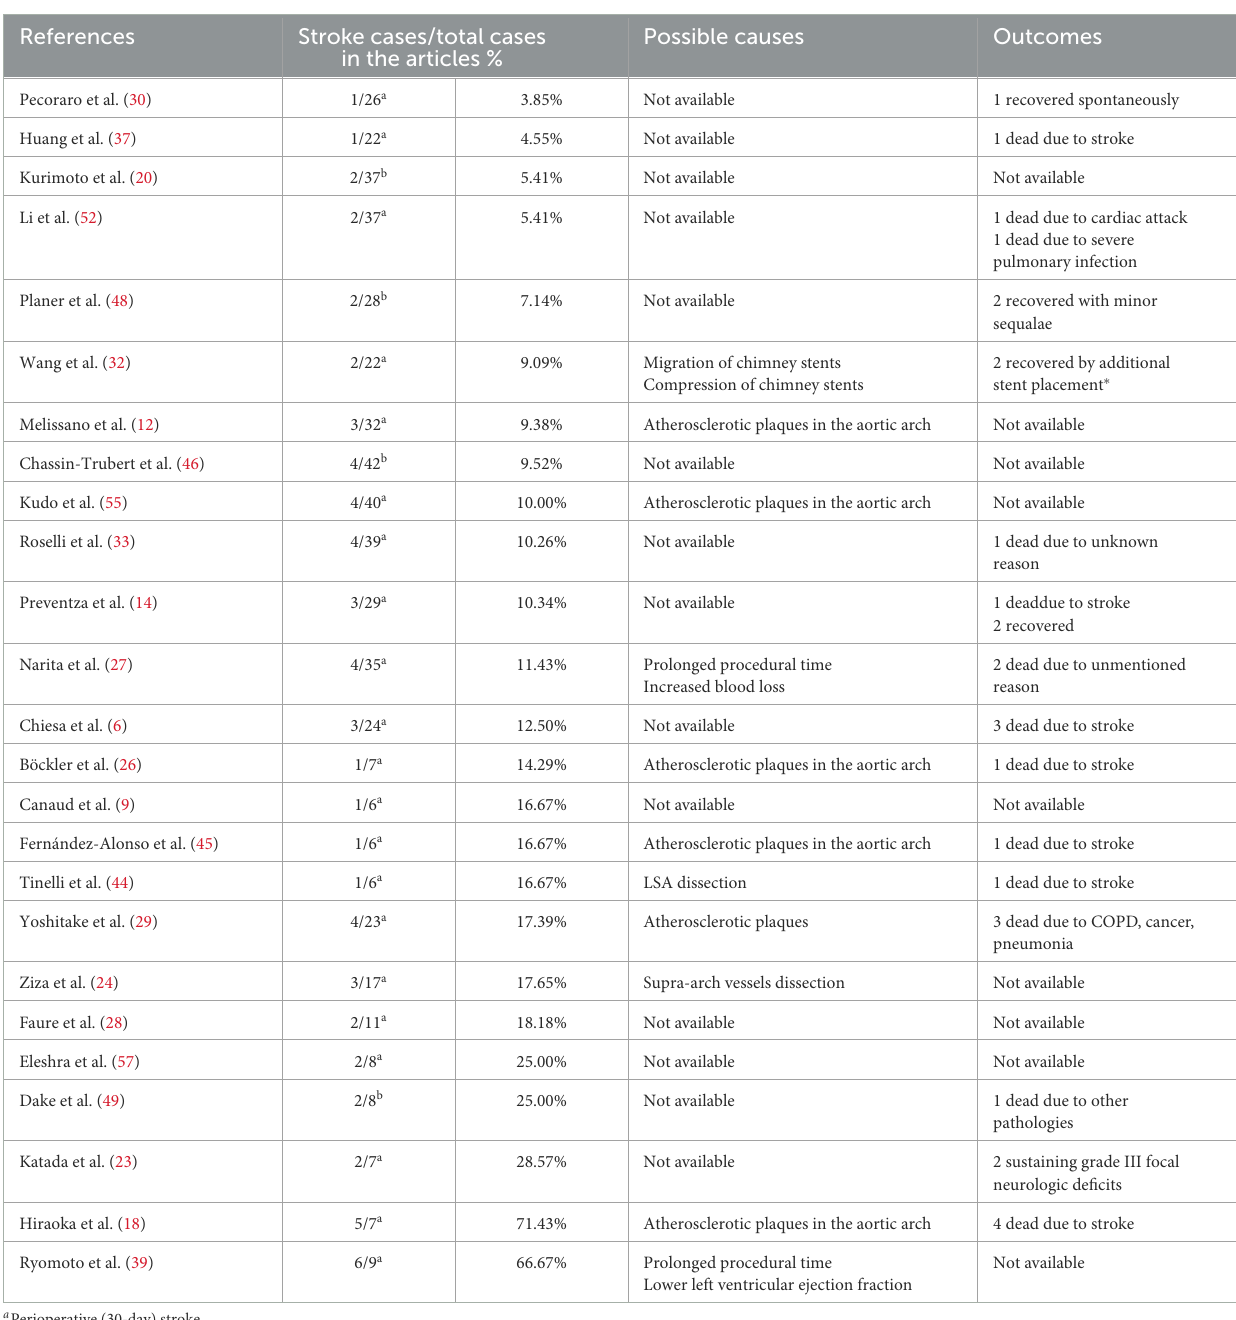
TABLE 6 Possible causes and outcomes of strokes in included